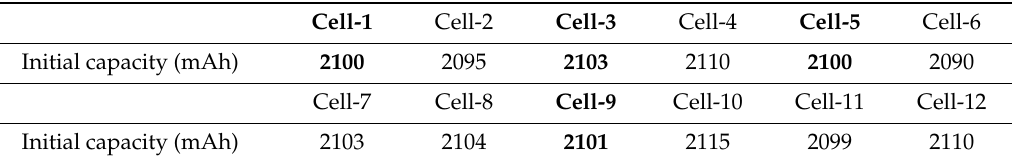
Figure 1. ( a ) Initial capacity distribution. ( b ) Normal probability plot of the initial capacities. ( c ) Initial resistance distribution. ( d ) Normal probability plot of the initial resistances. Table 2. Initial capacities of the focal 12